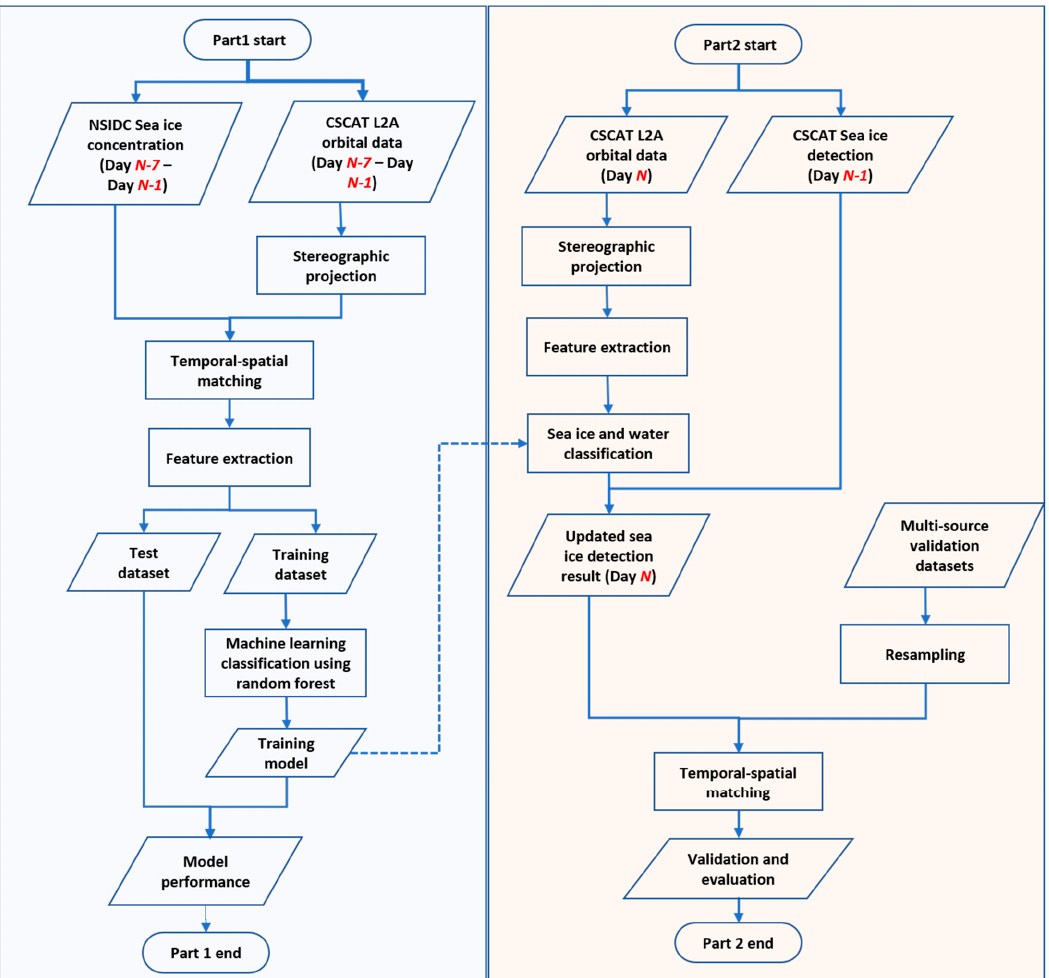
Figure 3. The flowchart of sea ice monitoring based on machine learning with CSCAT measurement.